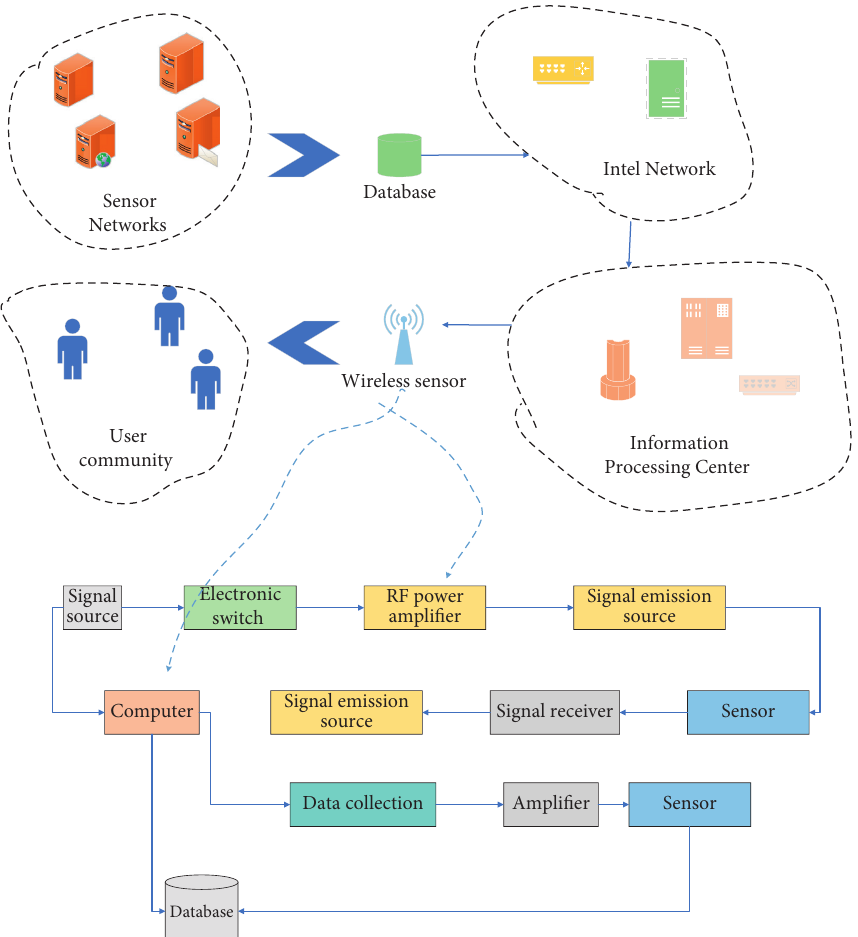
Figure 1: Wireless transceiver experimental system for passive, wireless temperature